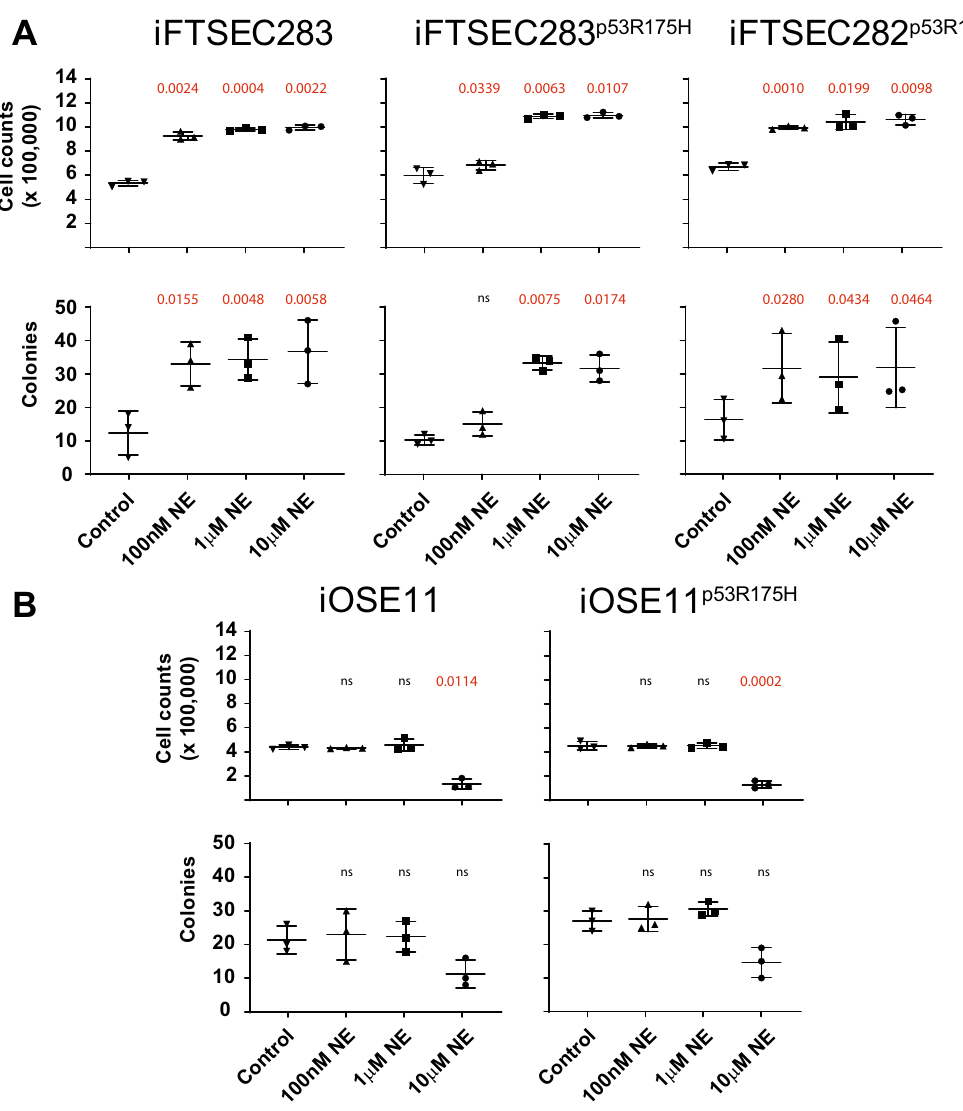
Figure 2. Effect of long-term exposure to NE on cell survival. ( A ) Short-term proliferation and ( B ) colony forming assays capacity of cells treated with NE (100 nM, 1 µM, 10 µM) or mock treated for 4 months. Short- term proliferation and colony forming assays were conducted with the same concentrations (or mock treatment) as the long-term treatment. Statistical significance (p value) in a paired t-test in relation to control is indicated. ns, not